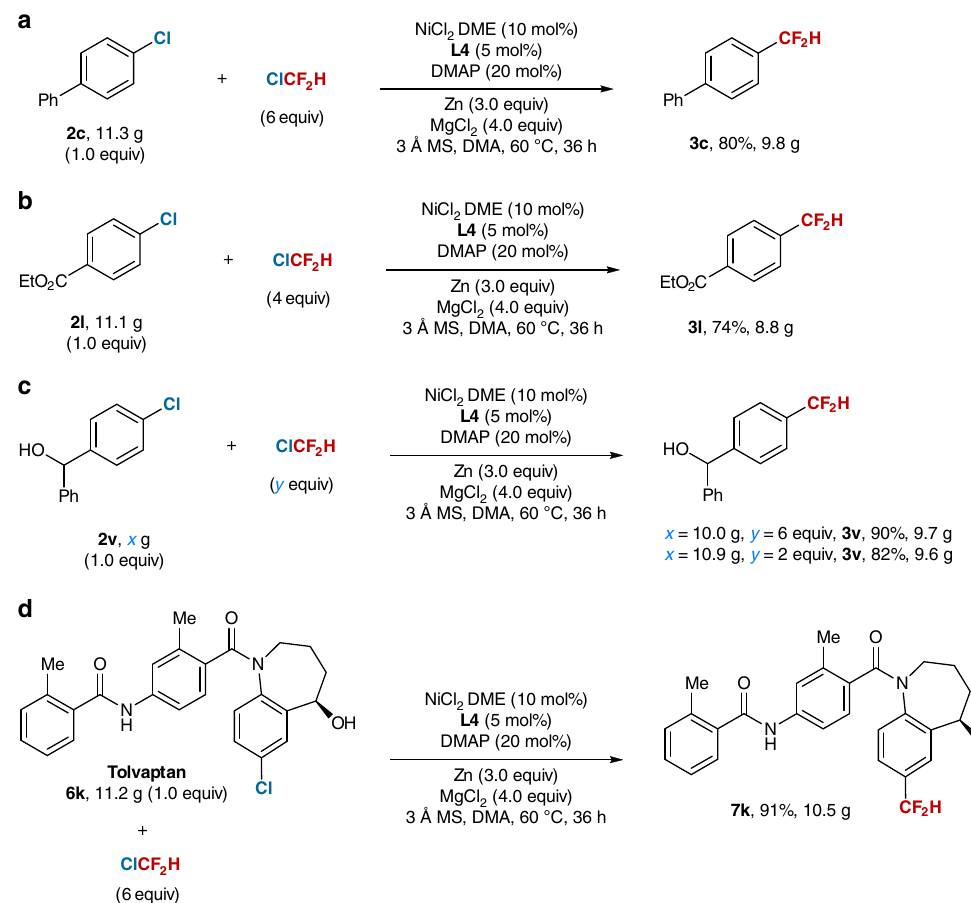
Fig. 2 Ten-gram scale reaction of aryl chlorides with ClCF 2 H. a Reaction of ClCF 2 H with 2c . b Reaction of ClCF 2 H with 2l . c Reaction of ClCF 2 H with 2v . d Reaction of ClCF 2 H with 6k